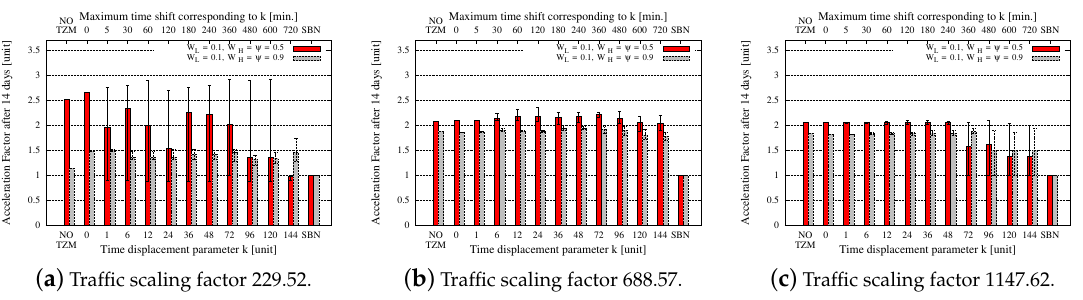
Figure 10. AF avg over all LCs (after 14 days) and over all SVMs in the Abilene-based network using two EWA settings. The error bars indicate the minimum and maximum values over all